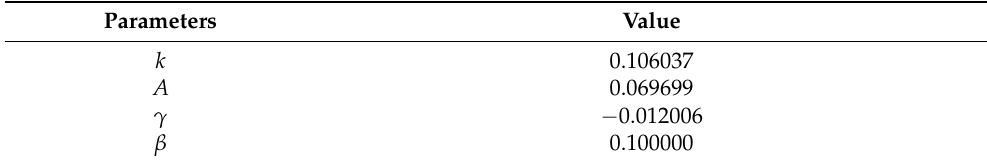
Table 2. Parameter identification result of CBW